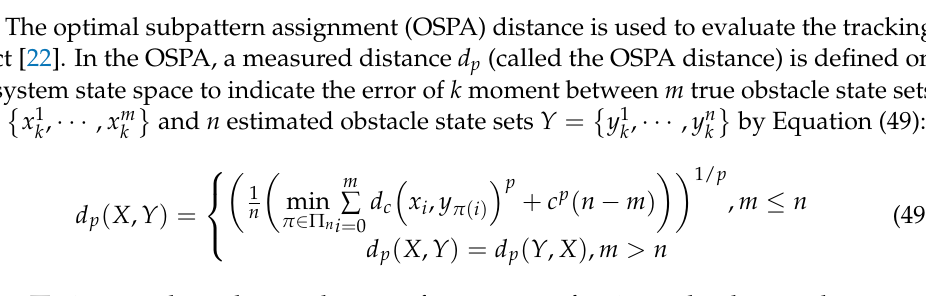
Figure 10. Comparative analysis of data. ( a ) Obstacle position comparison, ( b ) obstacle velocity